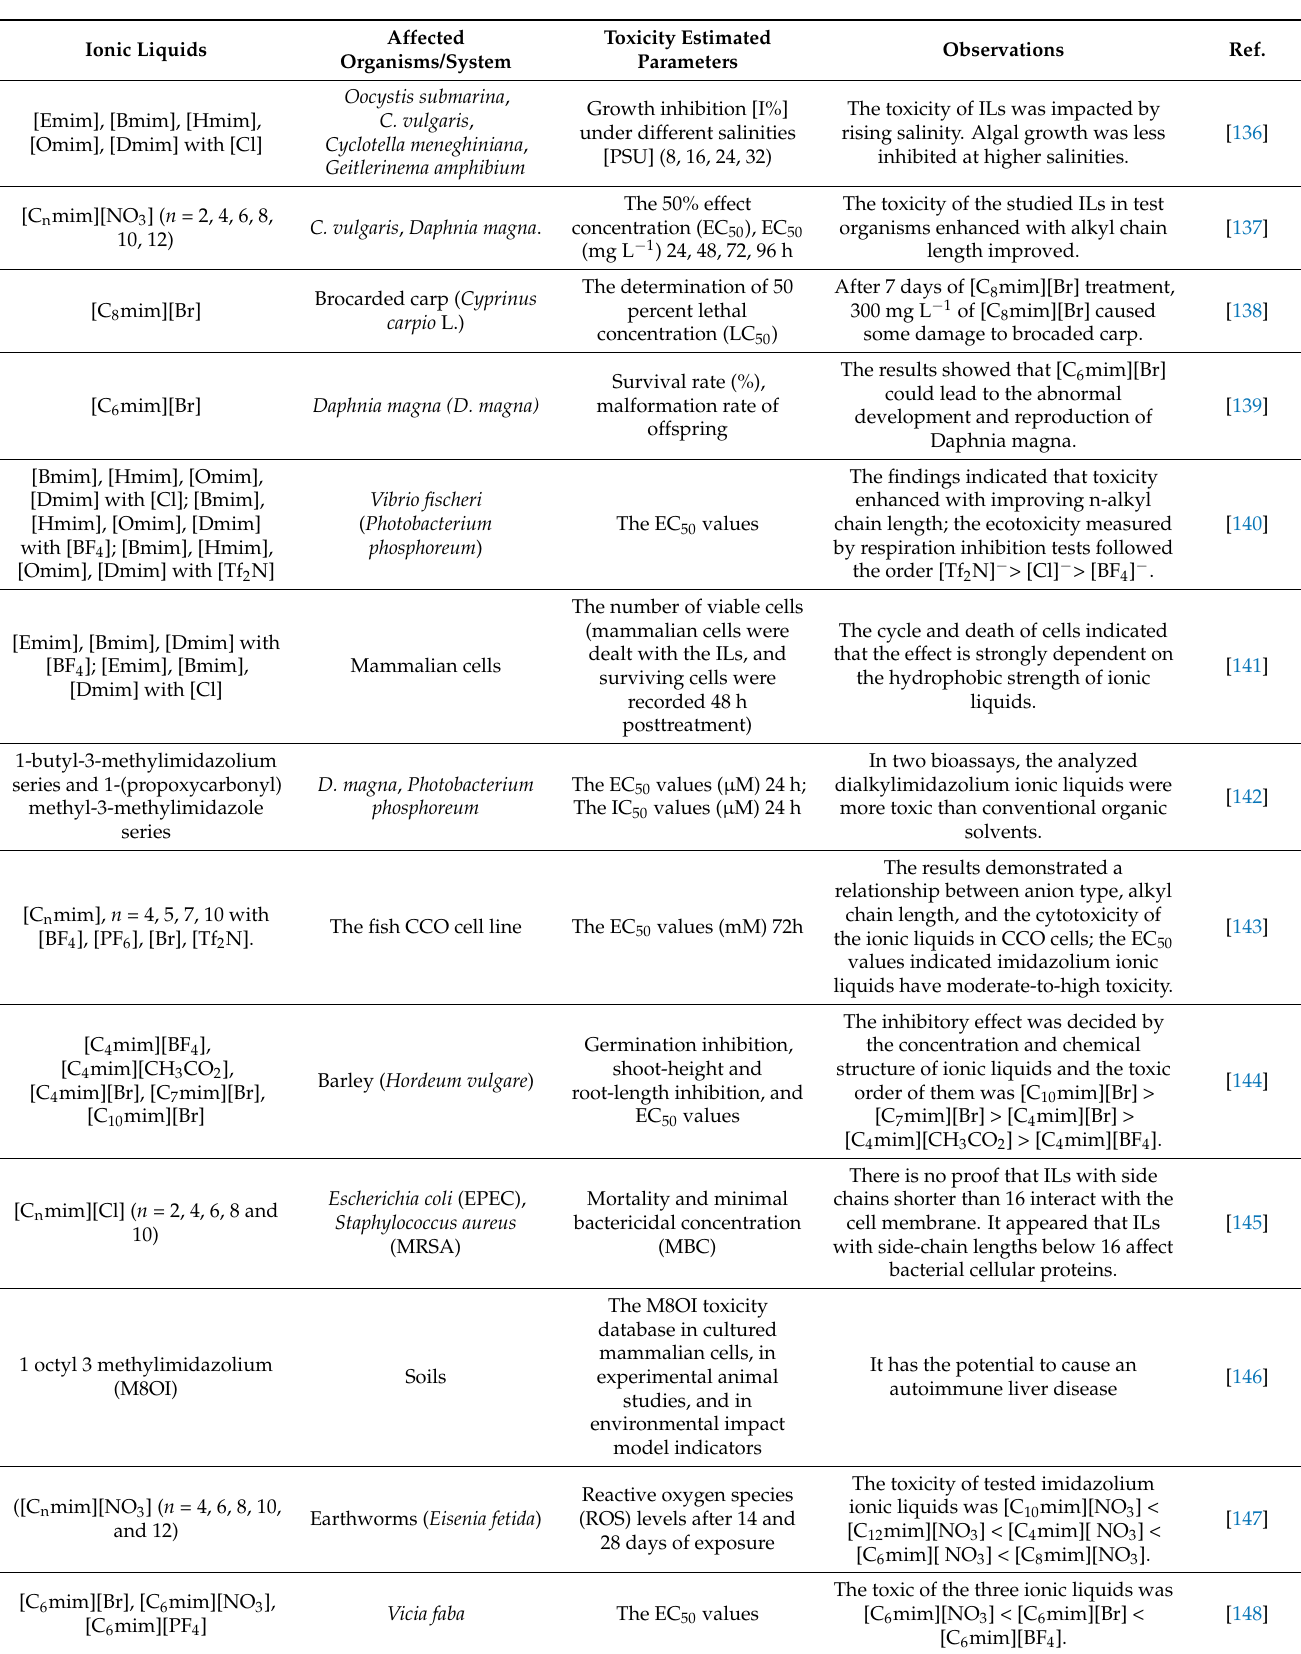
Table 5. Toxicity of imidazolium ionic